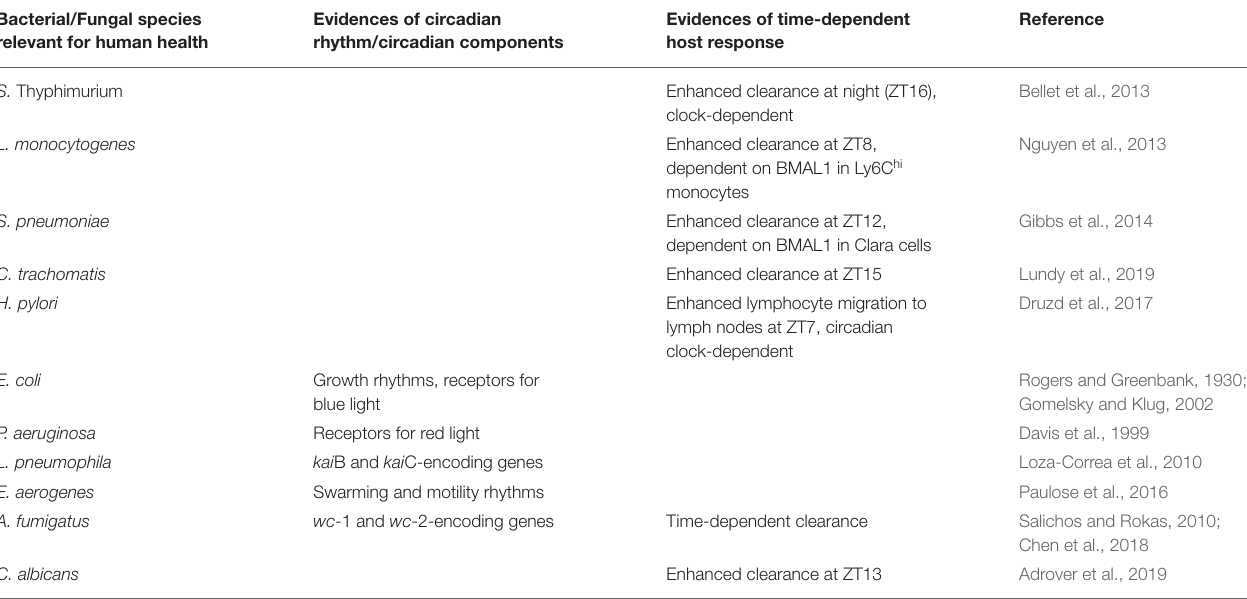
TABLE 1 | Regulation of host and/or microbes circadian rhythms in selected bacterial and fungal infections. Bacterial/Fungal species relevant for human